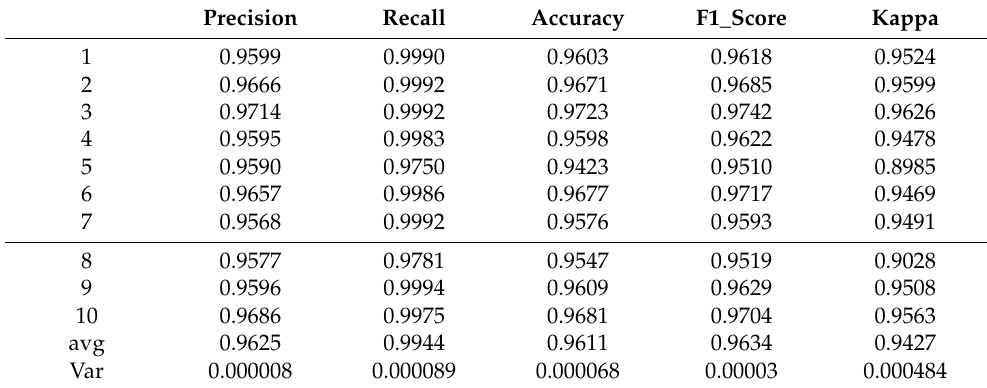
Table 7. Metrics result of ten SA-FEM